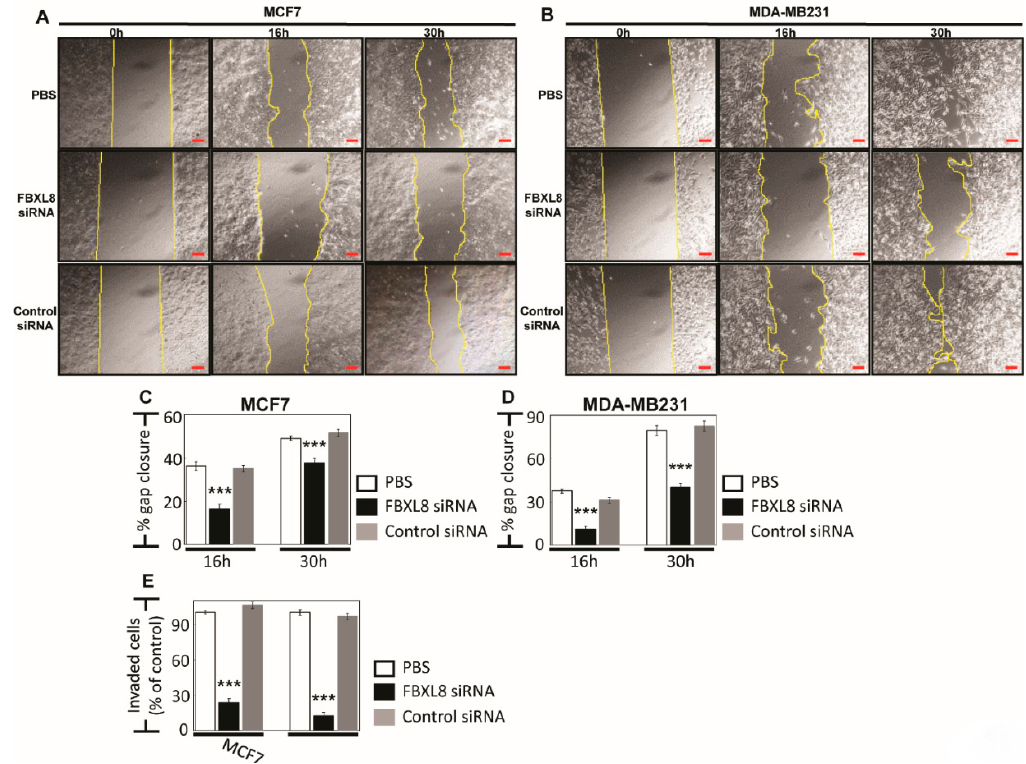
Figure 4. Knockdown of FBXL8 effectively suppressed BRCA migration and invasion. Cell migration assay was performed for: ( A ) MCF7 and ( B ) MDA-MB231 cells. Corresponding quantitative results are shown in ( C ) and ( D ). Compared with control siRNA, FBXL8 siRNA-treated cells showed significant decrease in the rate of migration. For each treatment, the migration rate (% gap closure) was normalized to the corresponding 0 h time point controls. Cell invasion assay and corresponding quantitative results are shown in Figure S6 and ( E ), respectively. We showed that FBXL8-knockdown effectively reduced cell invasion. Data are representative of means ± SD ( n = 3). Scale bar is 100 μ m, shown as the red color line ( — ). ***, p < 0.001.